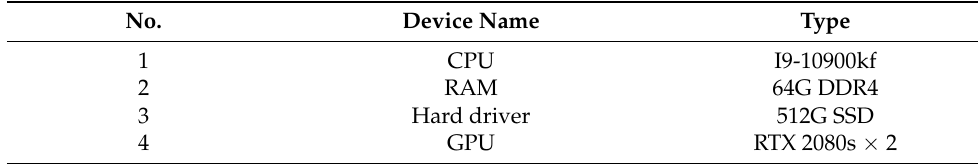
Table 6. Specification of the high-performance